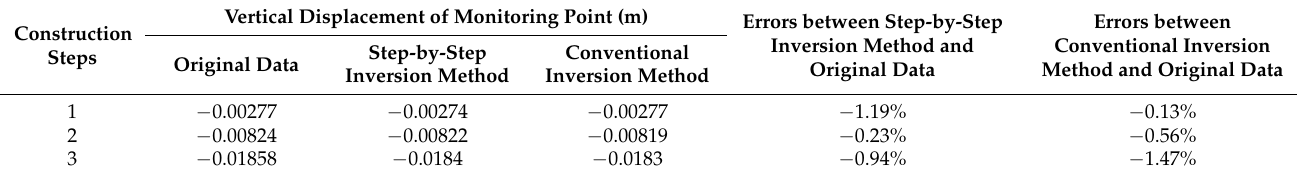
Table 4. Calculated vertical displacement and errors.